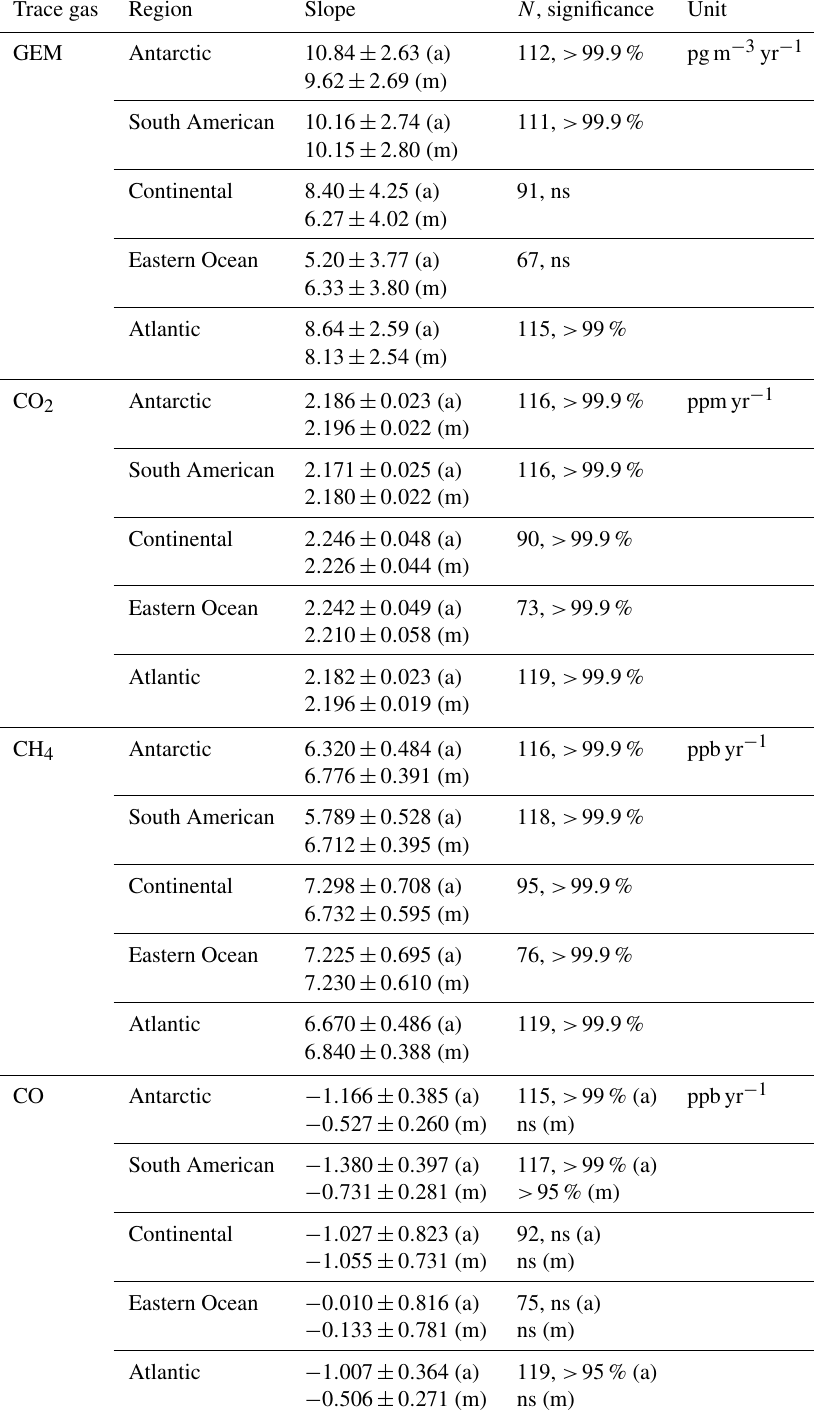
Table 4. Trends of GEM, CO 2 , CH 4 , and CO calculated by least-squares fit from monthly averages (a) and medians (m). Months with less than 10 measurements were not considered, which applies to most Local months. Trends of 222 Rn and O 3 were not significant (ns) for all